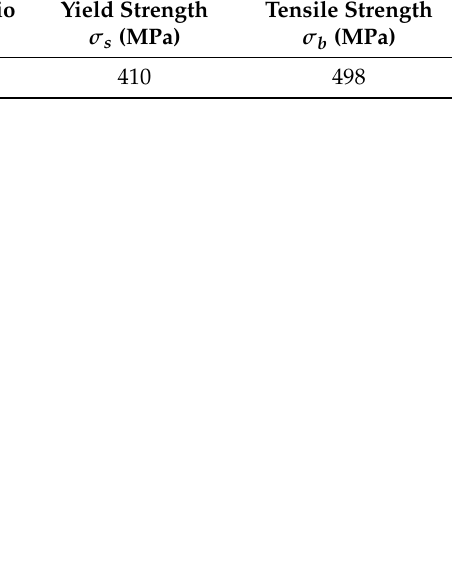
Figure 2. Engineering strain–stress curve of pipe for testing.